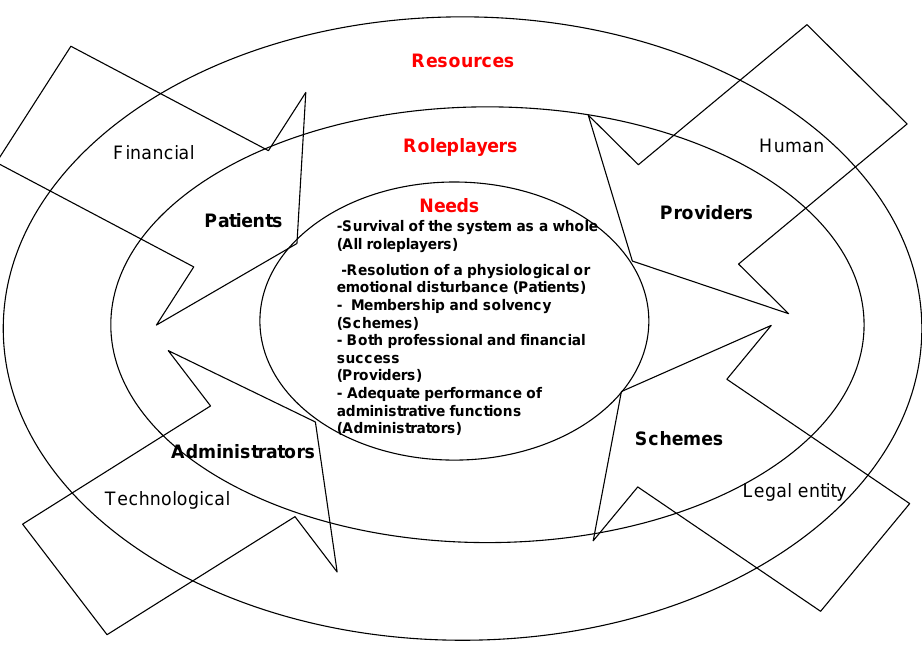
Figure 6: Resources, role-players and needs – the ideal scenario